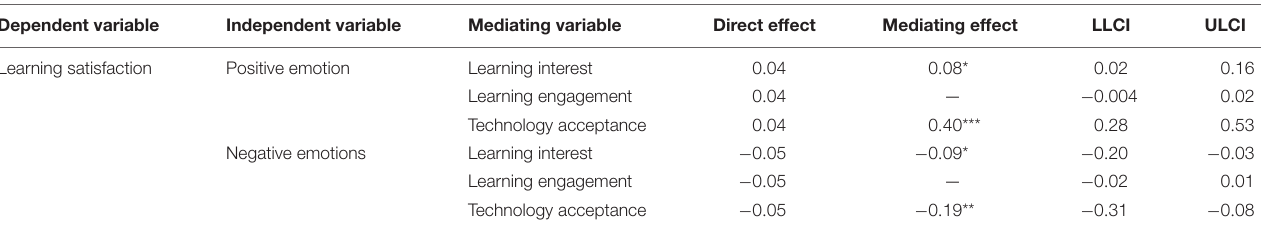
FIGURE 2 | Mediation model for effects of academic emotions on learning satisfaction. The solid arrow represents the significant path, and the dotted arrow represents the insignificant path. β is the path coefficient. CI, confidence interval. * p < 0.05, ** p < 0.01, *** p < 0.001. TABLE 2 | Bootstrapping analysis of the mediating effect